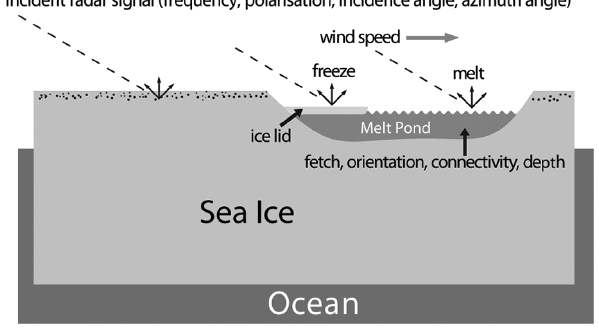
Figure 1. Schematisation of the radar and target parameters under consideration for the in situ study of microwave backscatter from a snow-free level first-year sea ice during